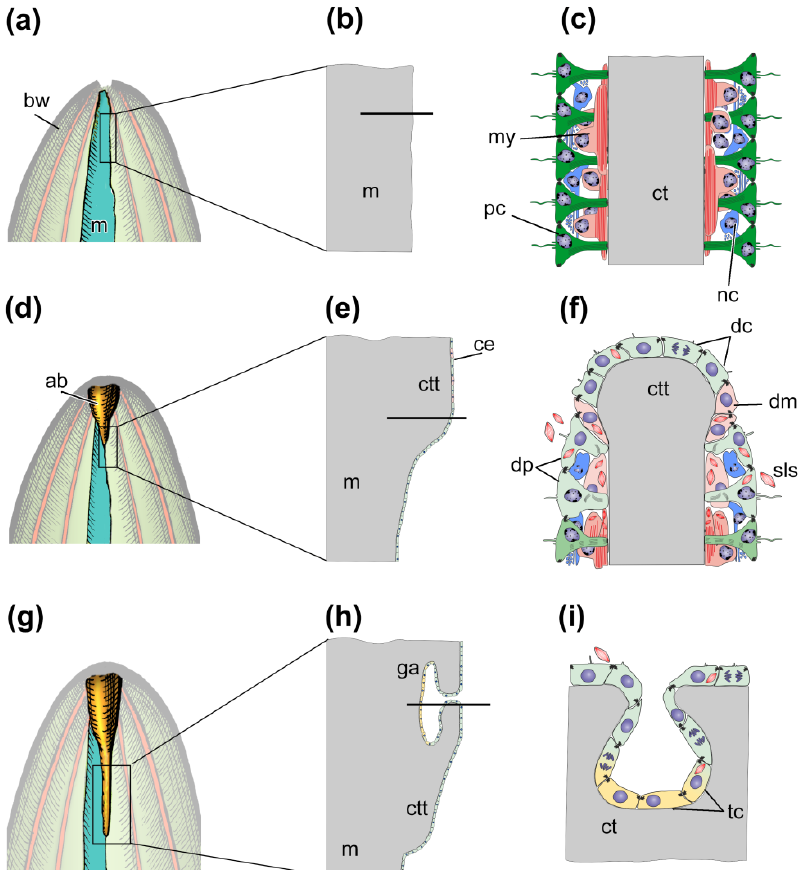
Figure 4. Scheme of regeneration of anterior part of digestive system after anterior evisceration. ( a ) Anterior part of holothurian just after evisceration; ( b ) Longitudinal section of the region of the mesentery, which is marked by the rectangle in ( a ). ( c ) Transverse section of the region of mesentery which is marked by solid line in ( b ). ( d ) Anterior part of holothurian on third day post-evisceration; ( e ) Longitudinal section of the region of the tissue thickening, which is marked by the rectangle in ( d ). ( f ) Transverse section of the region of connective tissue thickening which is marked by solid line in ( e ). ( g ) Anterior part of holothurian on seventh day post-evisceration; ( h ) Longitudinal section of the region of gut anlage, which is marked by the rectangle in ( g ). ( i ) Transverse section of the site of embedding of coelomic epithelial cells into connective tissue thickening which is marked by solid line in ( h ). ab, aquapharyngeal bulb; bw, body wall; ce, coelomic epithelium; ct, connective tissue; ctt, connective tissue thickening; dc, de-differentiated coelomic epithelial cell; dm, de-differentiating myoepithelial cell; dp, de-differentiating peritoneal cell; ga, anterior gut anlage; m, mesentery; my, myoepithelial cell; nc, nerve cell; pc, peritoneal cell; sls, myofilaments grouped into spindle-like structures, tc, coelomic epithelial cell during